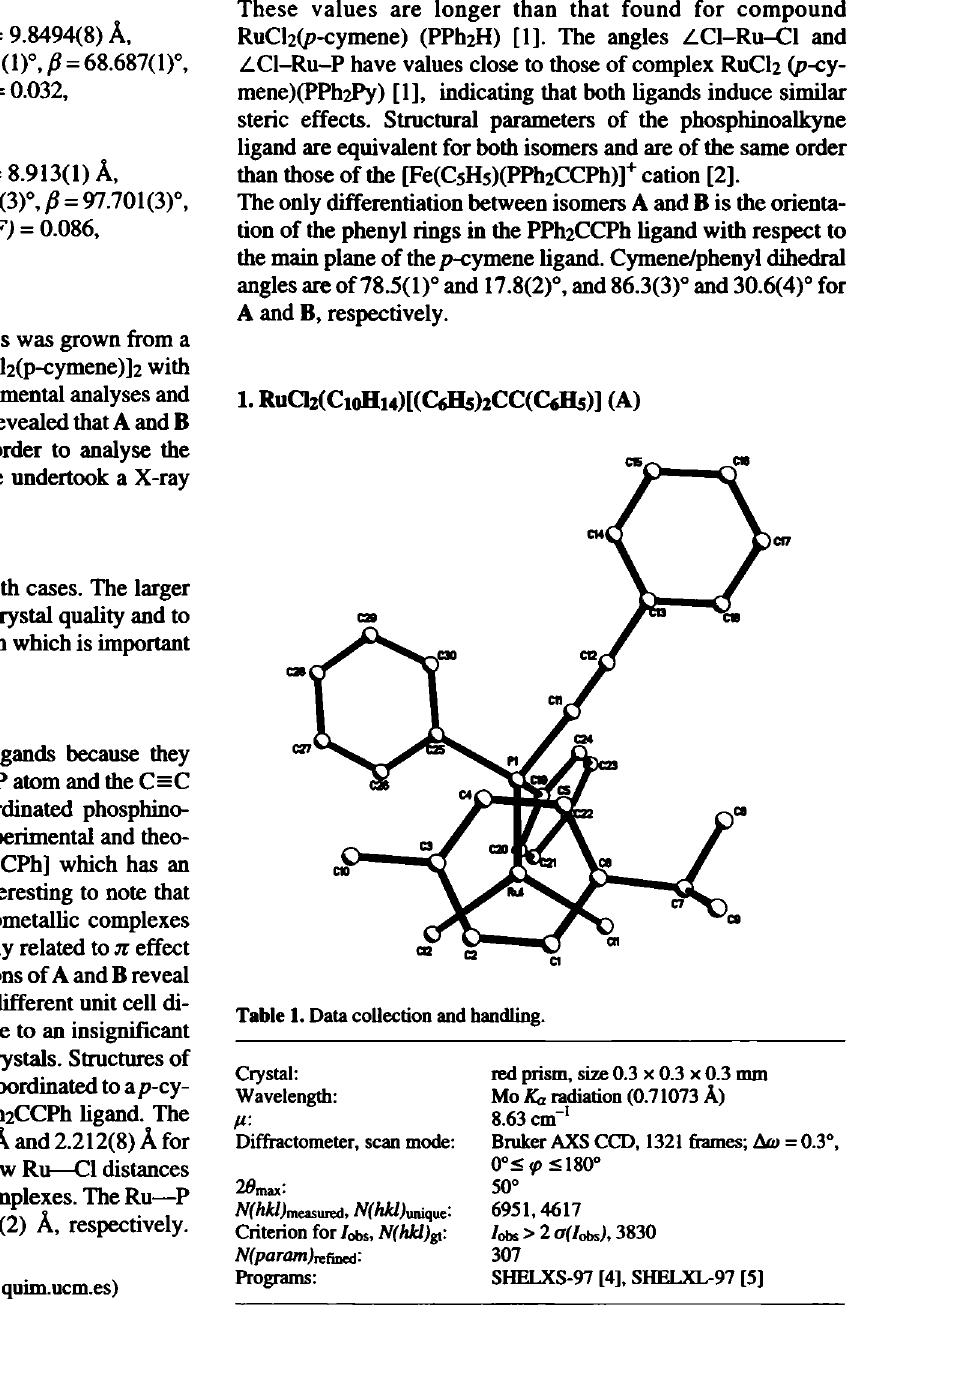
Table 1. Data collection and